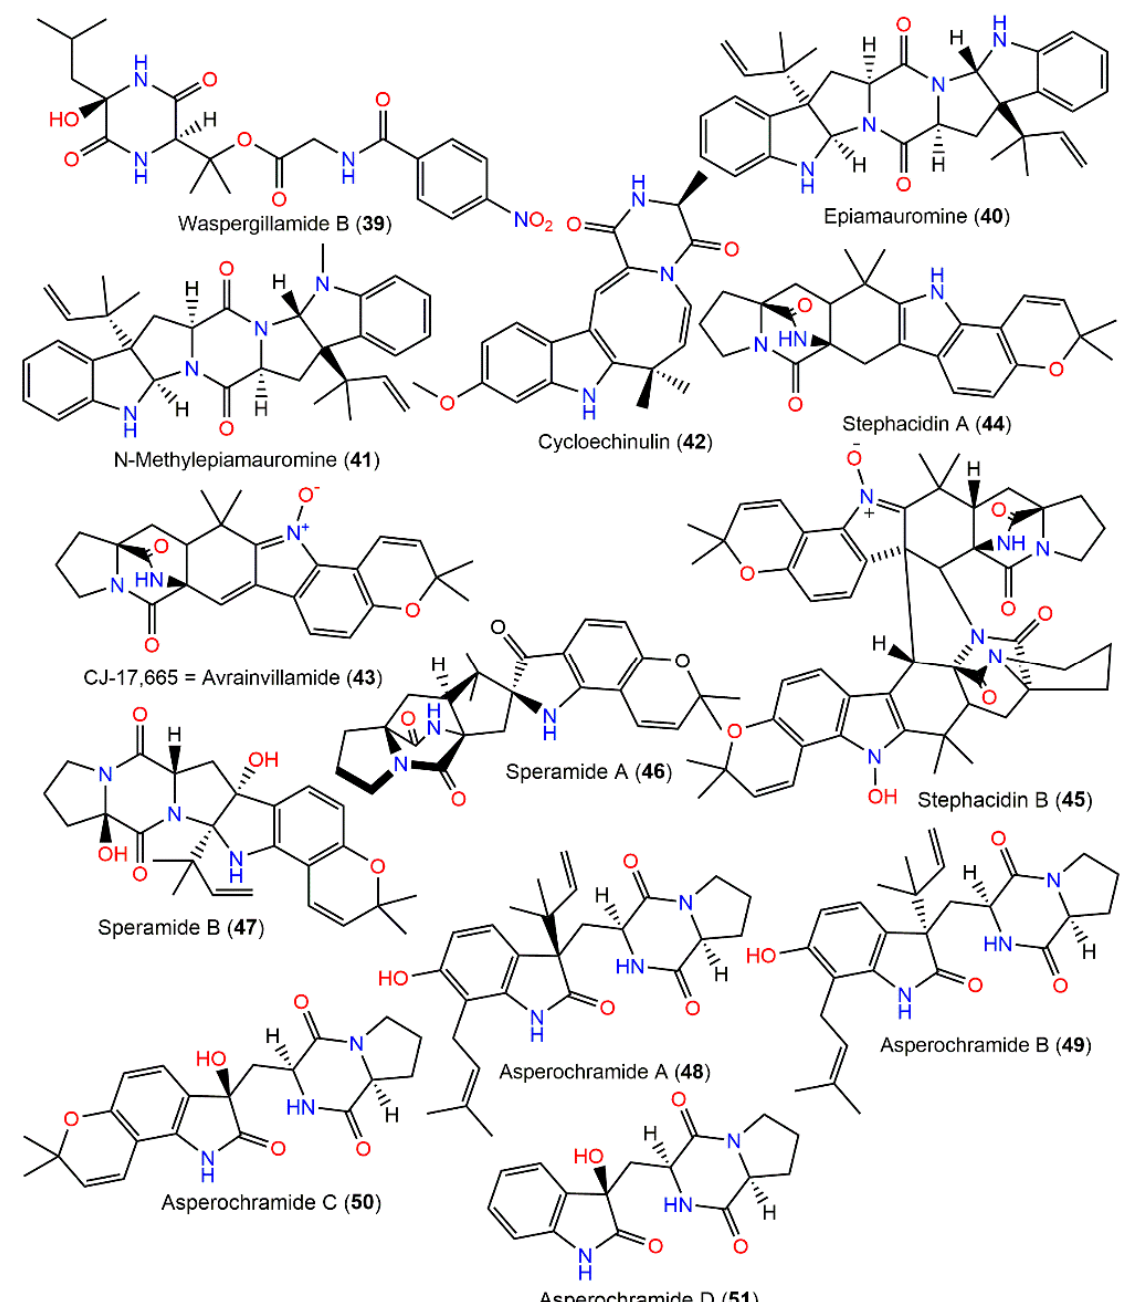
Figure 4. Diketopiperazines derivatives ( 39 – 51 ) reported from A. ochraceus.